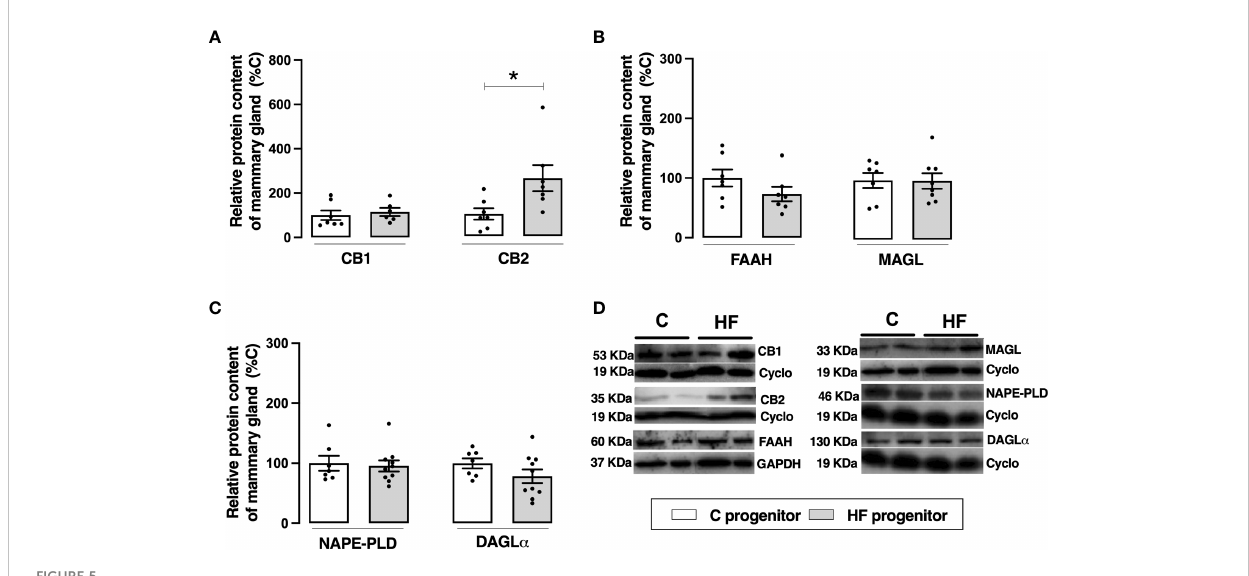
FIGURE 5 Effect of high-fat (HF) diet on the endocannabinoid system in the mammary gland of rat progenitors. (A) Type-1 cannabinoid receptor (CB1) and type-2 cannabinoid receptor (CB2) protein content; (B) fatty acid amide hydrolase (FAAH) and monoacylglycerol lipase (MAGL) protein content; (C) N-acyl phosphatidylethanolamine phospholipase D (NAPE-PLD) and diacylglycerol lipase (DAGL) protein content of mammary gland of control (C) and HF progenitors. (D) representative blots are shown. Data are expressed as percentage of control group (set at 100%) ± standard deviation.